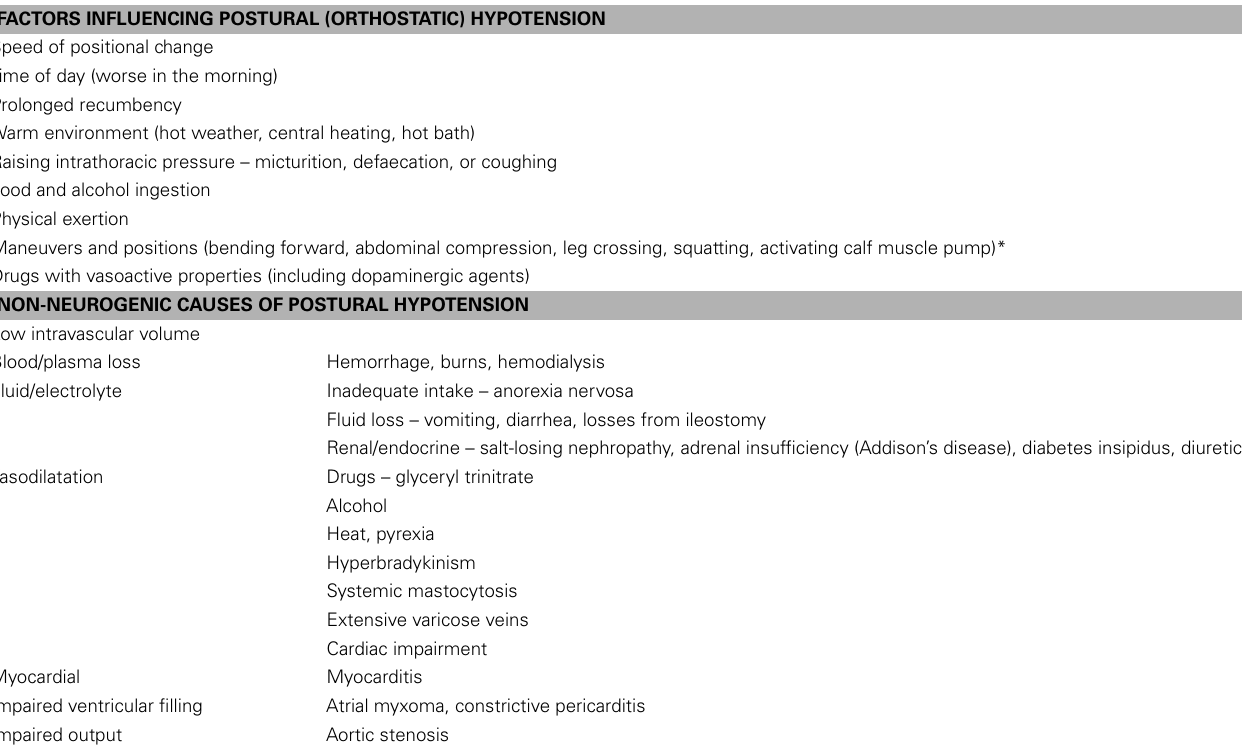
Table 1 | Factors influencing postural (orthostatic) hypotension, adapted from Mathias et al. (2013) . FACTORS INFLUENCING POSTURAL (ORTHOSTATIC) HYPOTENSION Speed of positional